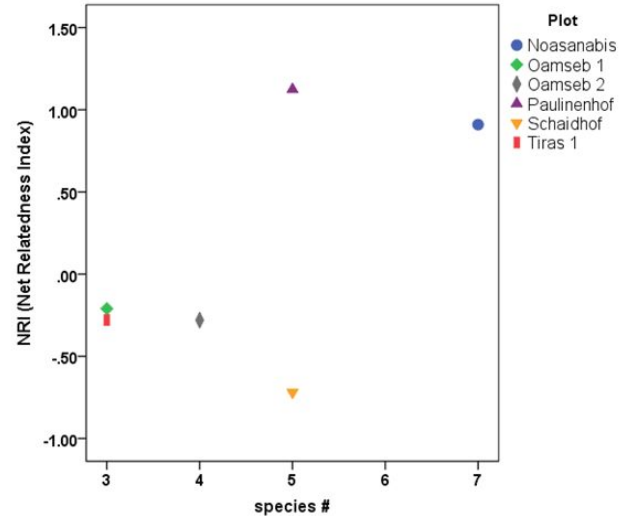
Fig 3. Indices of the phylogenetic community structure using the null model independent swap with the presence/absence data showing the NRI for all plots with the number of species per plot. The number of species did not correlate significantly with the